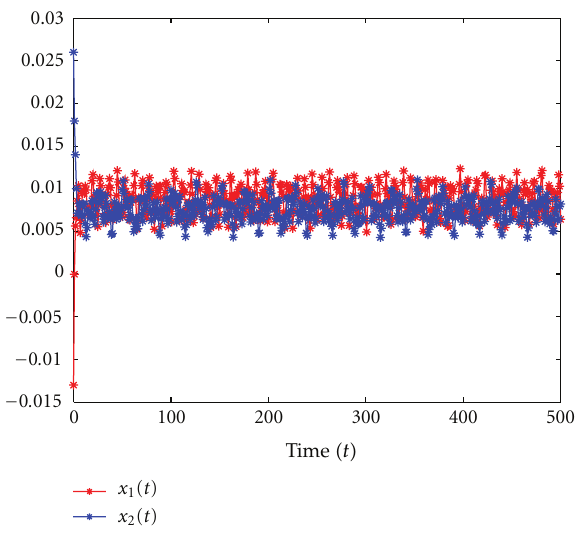
Figure 4: Transient response of state x 1 ,x 2 in Example 4.2.